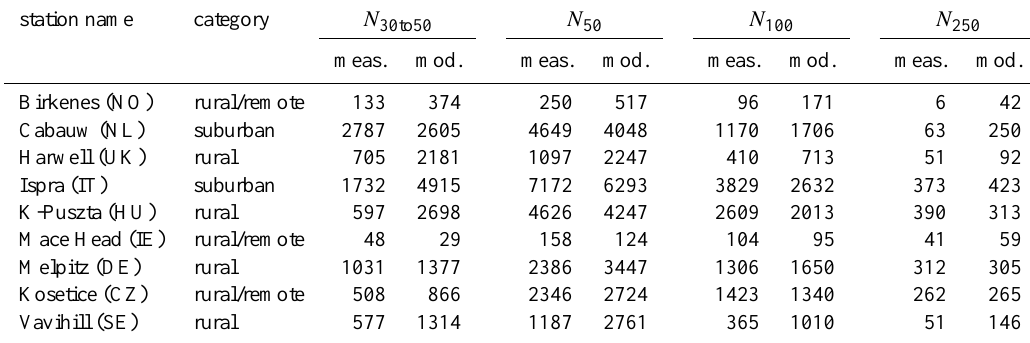
Table 3. Comparison of number concentrations in different size ranges after Asmi et al. (2011) for number size distributions during the autumn 2008 simulation. N 30to50 : 30 to 50nm, N 50 : above 50nm, N 100 : above 100nm, N 250 : above 250nm. Note that the N 250 parameter has a larger uncertainty than the others due to very low sampling rates.